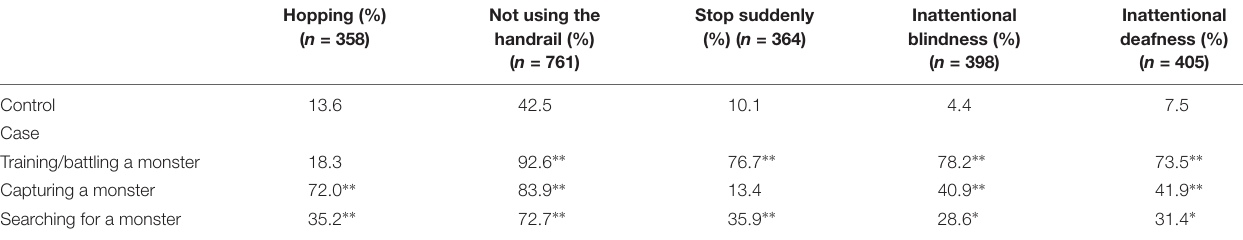
TABLE 2 | Risk-taking behaviors and inattentional blindness/deafness of the case and control groups.